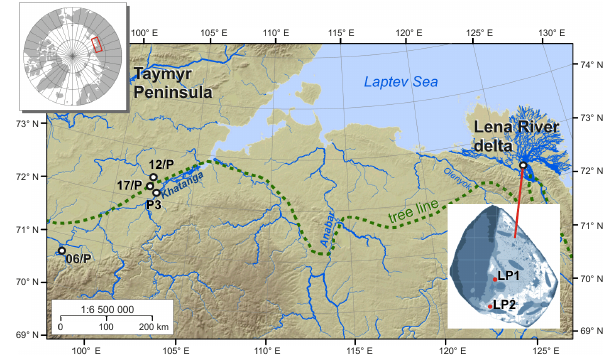
Figure 1. The Khatanga study sites are located in the south-east of the Taymyr Peninsula and both the sites on Samoylov Island are in the southern Lena River delta (Map by Th.